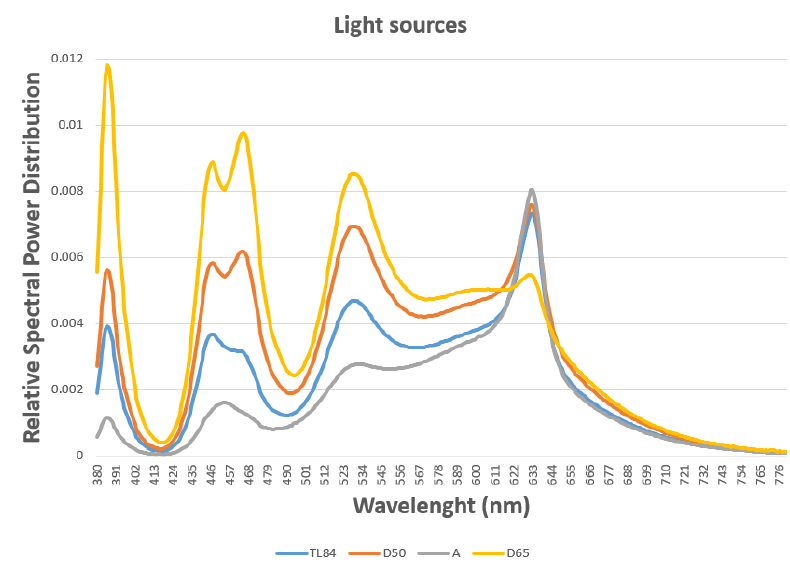
Figure 5. Absolute Spectral Power Distribution of different light